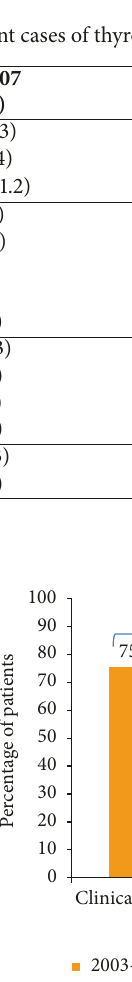
Figure 1: Tumor size categories by diagnostic period in members of the PSHI 2003-2012. Figure 2: Mechanism of detection by diagnostic period in members of the PSHI